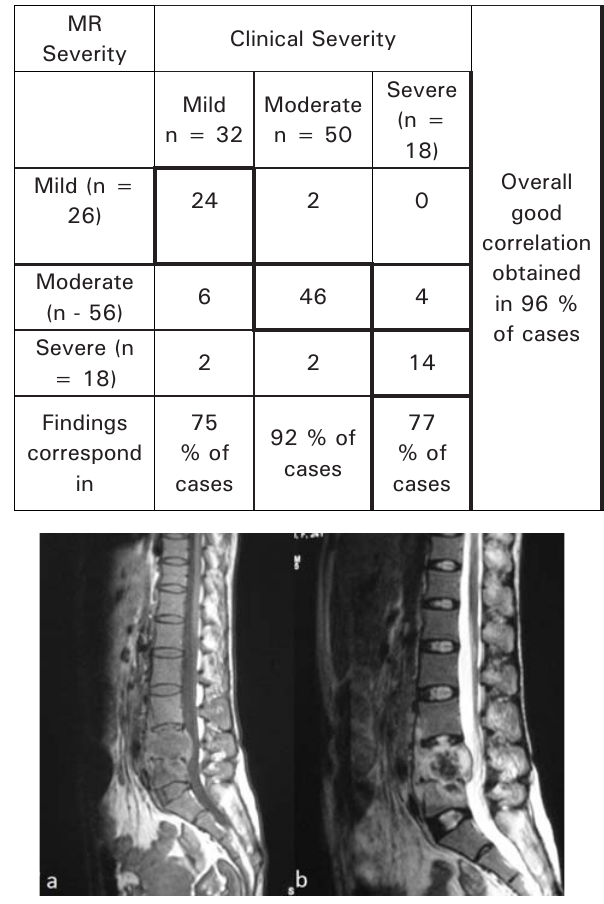
Figure 1. T1W (a) and T2W (b) sagittal MR images of lumbar spine demonstrates altered signal intensity of L4 and L5 vertebral bodies with loss of intervening intervertebral disc space. Evidence of intraosseous abscess, sub ligamentous spread and posterior extension into extradural spinal canal with narrowing of the thecal sac is also